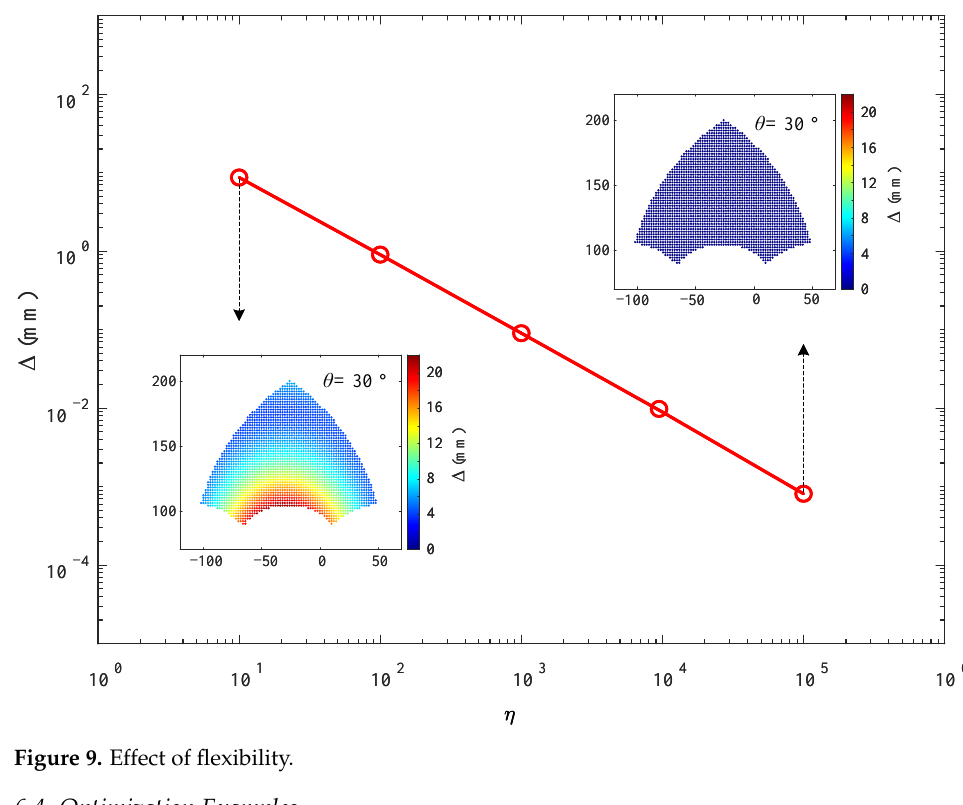
Figure 9. Effect of